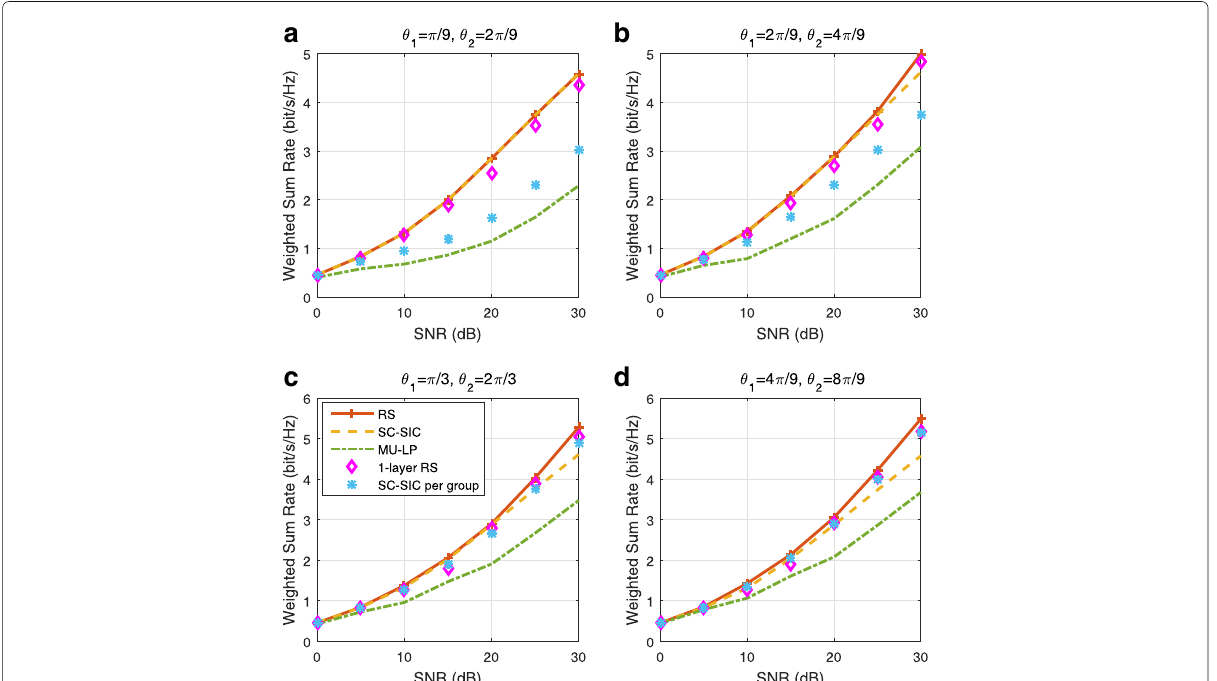
Fig. 42 Weighted sum rate versus SNR comparison of different strategies for overloaded three-user deployment with perfect CSIT, γ 1 = 1, γ 2 = 0.3, u 1 = 0.2, u 2 = 0.3, u 3 = 0.5, N t = 2, r th = [0.02,0.08,0.19,0.3,0.4,0.4,0.4] bit/s/Hz. a θ 1 = π/ 9, θ 2 = 2 π/ 9. b θ 1 = 2 π/ 9, θ 2 = 4 π/ 9. c θ 1 = π/ 3, θ 2 = 2 π/ 3.